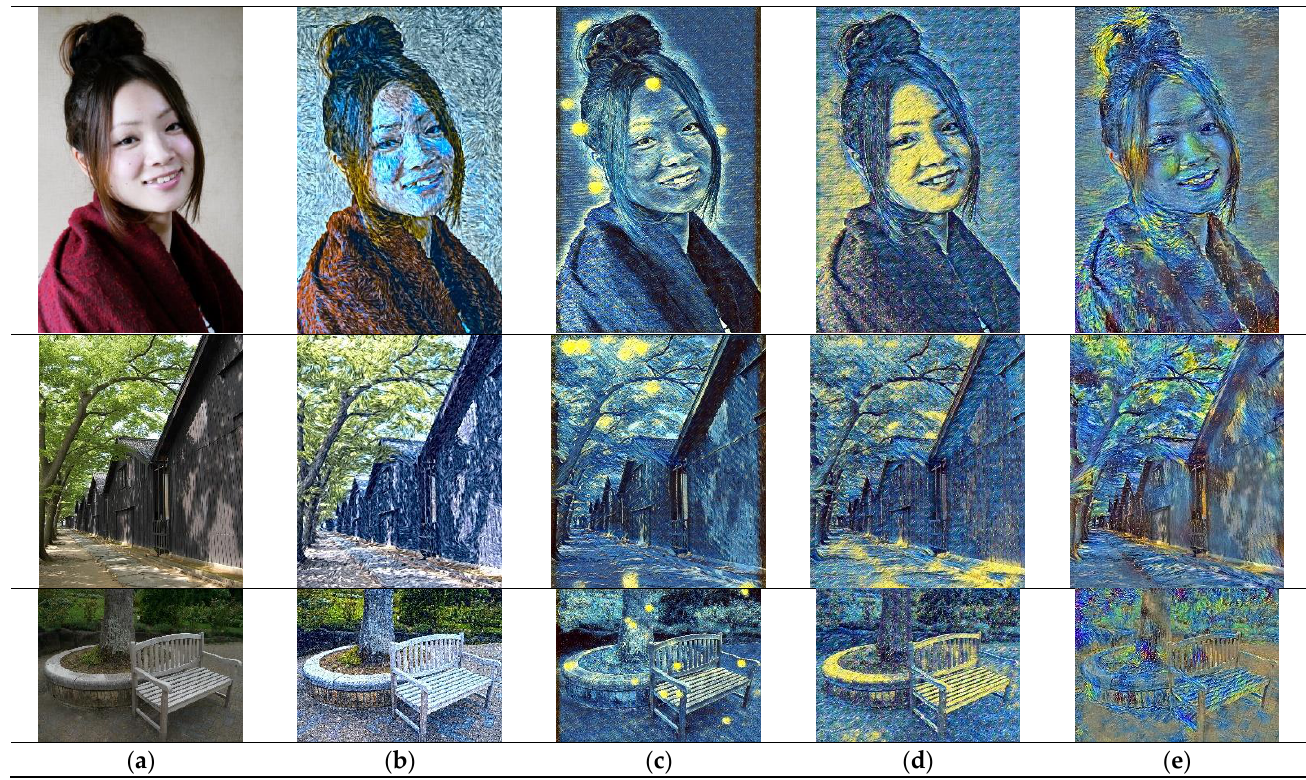
Figure 18. Visualized results of image rendering: ( a ) original image, ( b ) PTGCF, ( c ) FT, ( d ) PLST, ( e ) ASNN.